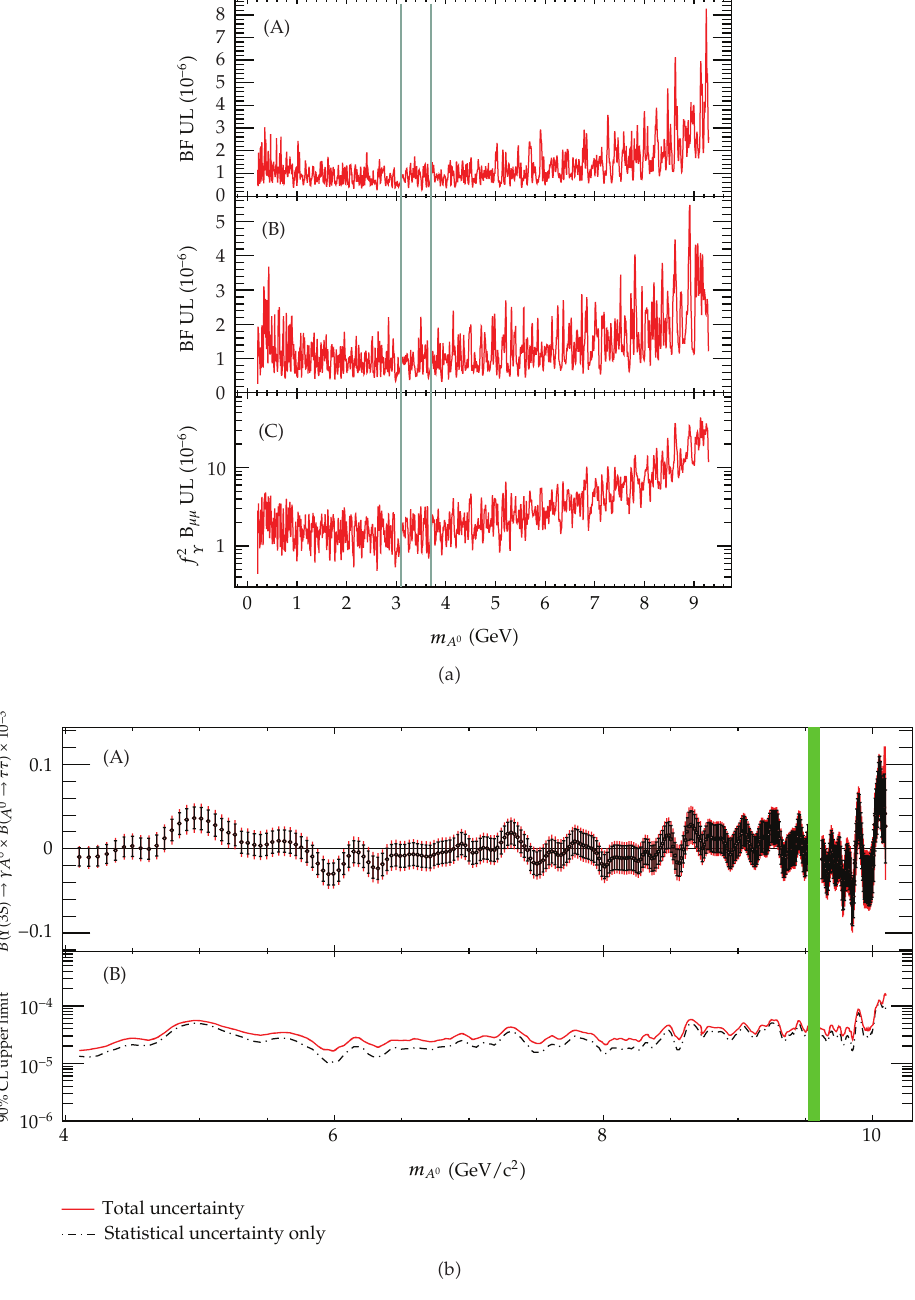
Figure 1: (cid:2) a (cid:3) 90% CL upper limit on the Υ(cid:2) 3 S (cid:3) → γA 0 , A 0 → μ (cid:8) μ − (cid:2) top (cid:3) and Υ(cid:2) 2 S (cid:3) → γA 0 , A 0 → μ (cid:8) μ − branching fractions (cid:2) middle (cid:3) as a function of the A 0 mass derived by BABAR . The limits on the product B (cid:2) A 0 → μ (cid:8) μ − (cid:3) f 2 Υ , are also shown (cid:2) bottom (cid:3) . The J/ψ and ψ (cid:2) 2 S (cid:3) regions (cid:2) solid bands (cid:3) are excluded from the search. (cid:2) b (cid:3) Product of branching fraction Υ(cid:2) 3 S (cid:3) → γA 0 , A 0 → τ (cid:8) τ − (cid:2) top (cid:3) and the corresponding 90% CL upper limit (cid:2) bottom (cid:3) as a function of the A 0 mass set by BABAR . The region corresponding to χ bJ (cid:2) 2 P (cid:3) → γ Υ(cid:2) 1 S (cid:3) transitions (cid:2) shaded band (cid:3) is